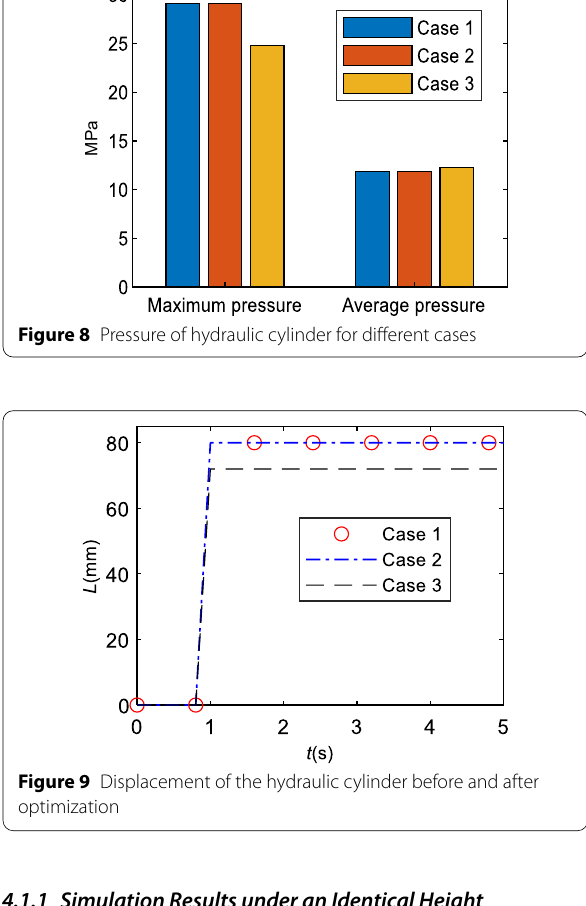
Table 1 Hydraulic parameters and structure parameters of